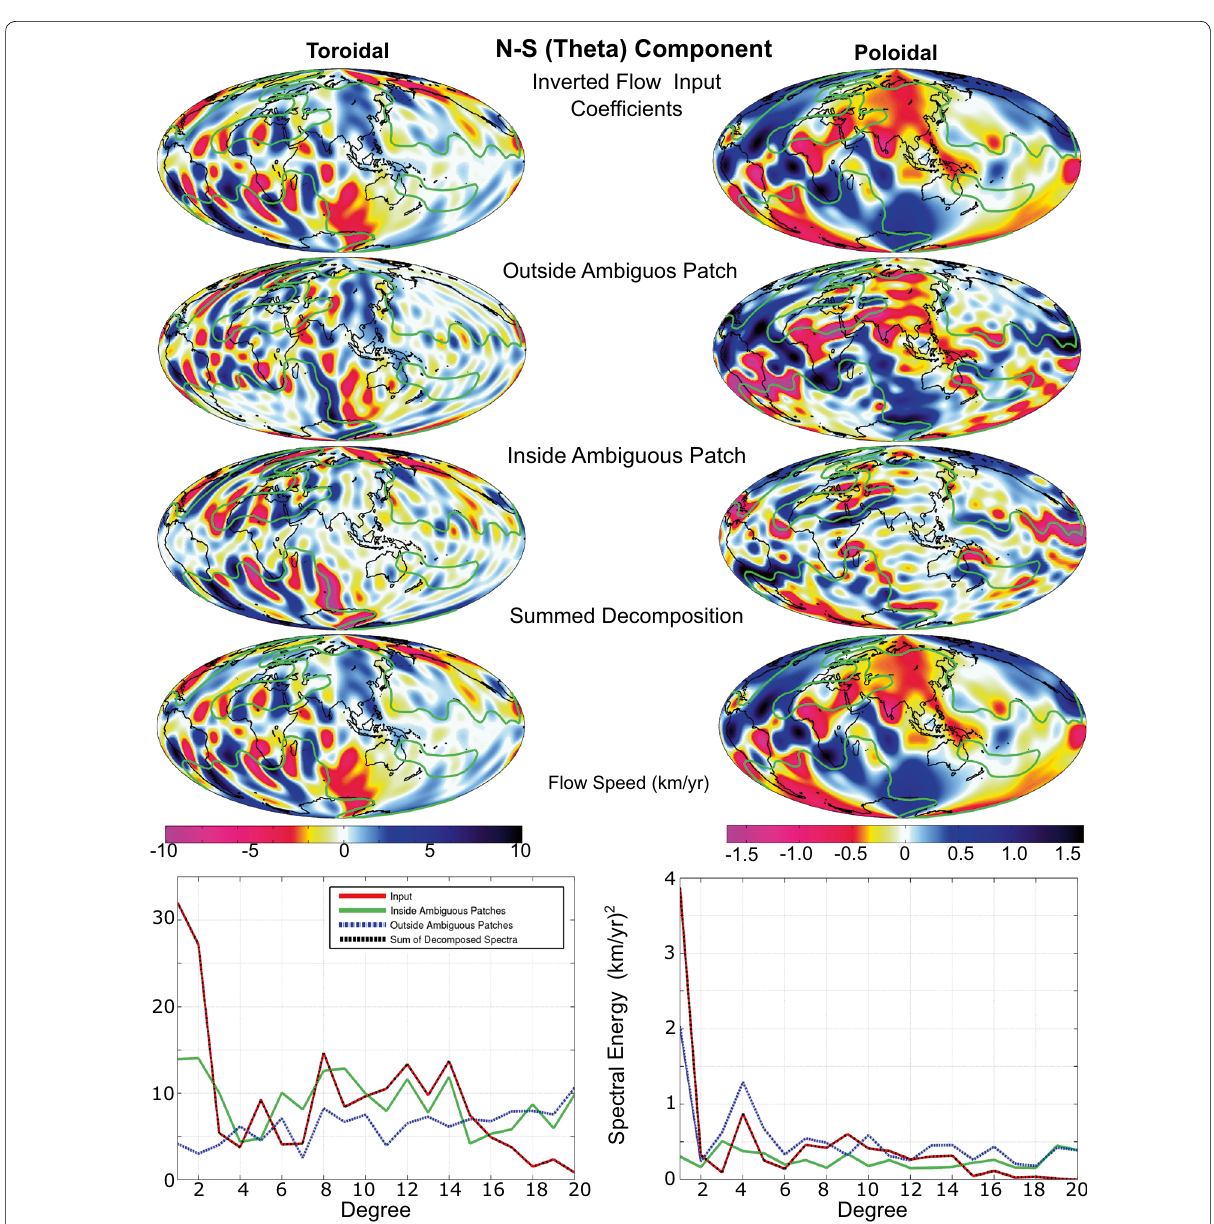
Fig. 8 Decomposition of inverted flow from satellite data in southward direction ( u θ ). Decomposition of steady flow model obtained from satellite 199 (coefficients out of 441) to represent flow within the patches. The Shannon number data (up to degree 20) using an ‘optimum’ value of K = 178 ) produced a similar decomposition, but the unwanted aliasing was slightly larger compared to our chosen ‘optimum’ K decomposition, ( K = which is shown in this